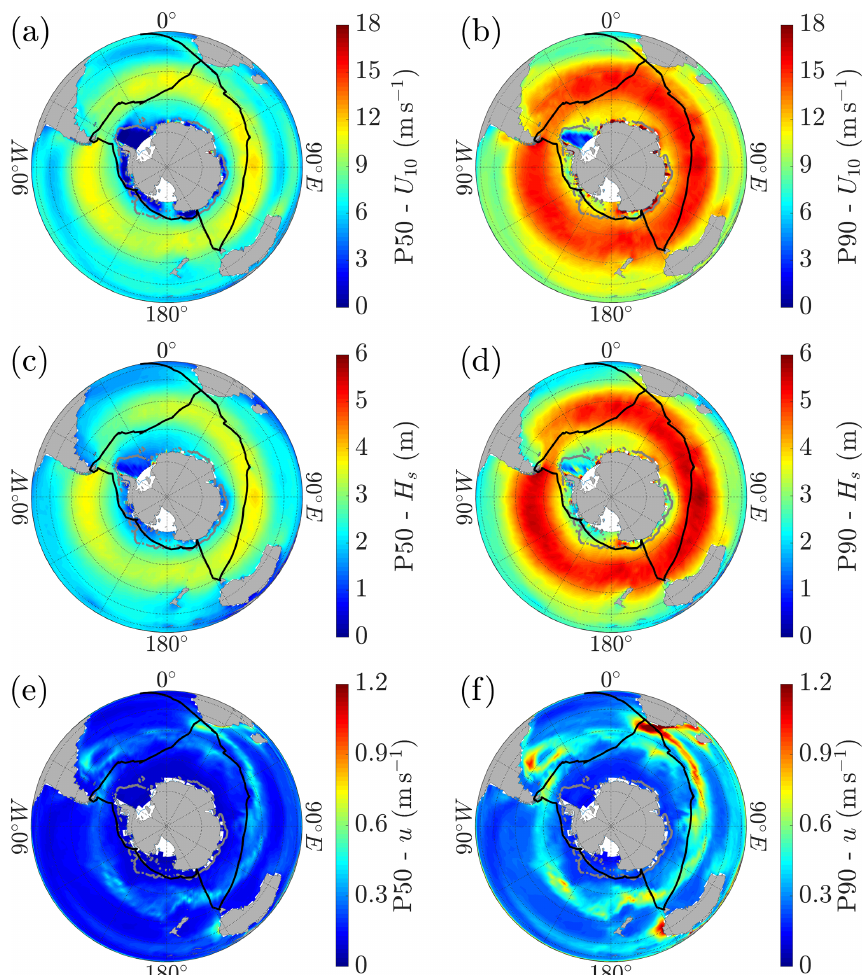
Figure 5. Wind speed ( U 10 ), significant wave height ( H s ), and surface current speed ( u ) climatology in Austral summer: (a) 50th percentile (median) wind speed, (b) 90th percentile wind speed, (c) 50th percentile (median) significant wave height, (d) 90th percentile significant wave height, (e) 50th percentile (median) surface current speed, and (f) 90th percentile surface current speed. Latitudes are shown every 15 ◦ (from 15 to 90 ◦ S) by thin lines; the route of the ACE voyage is reported as a black solid line; and the sea ice edge, defined by the 10% sea ice concentration, is shown as a grey solid